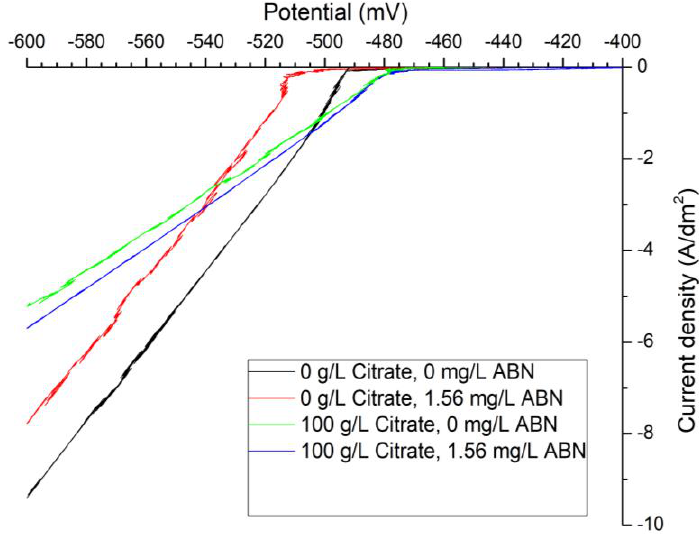
Figure 7. Role of the ABN additive in the MSA electrolyte without complexing agent and the MSA electrolyte containing 100 g/L tri-sodium citrate. Inhibition effect of the ABN in the citrate-rich electrolyte is covered by the presence of tin-citrate complexes.